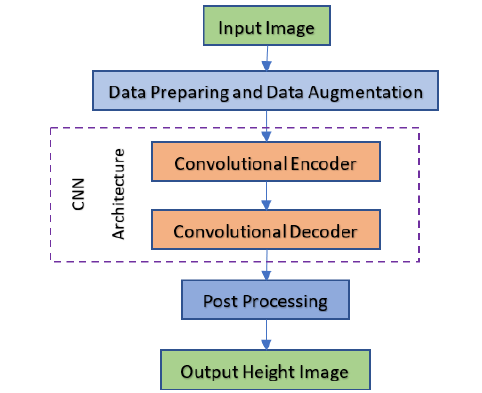
Figure 2 . The flowchart of the proposed